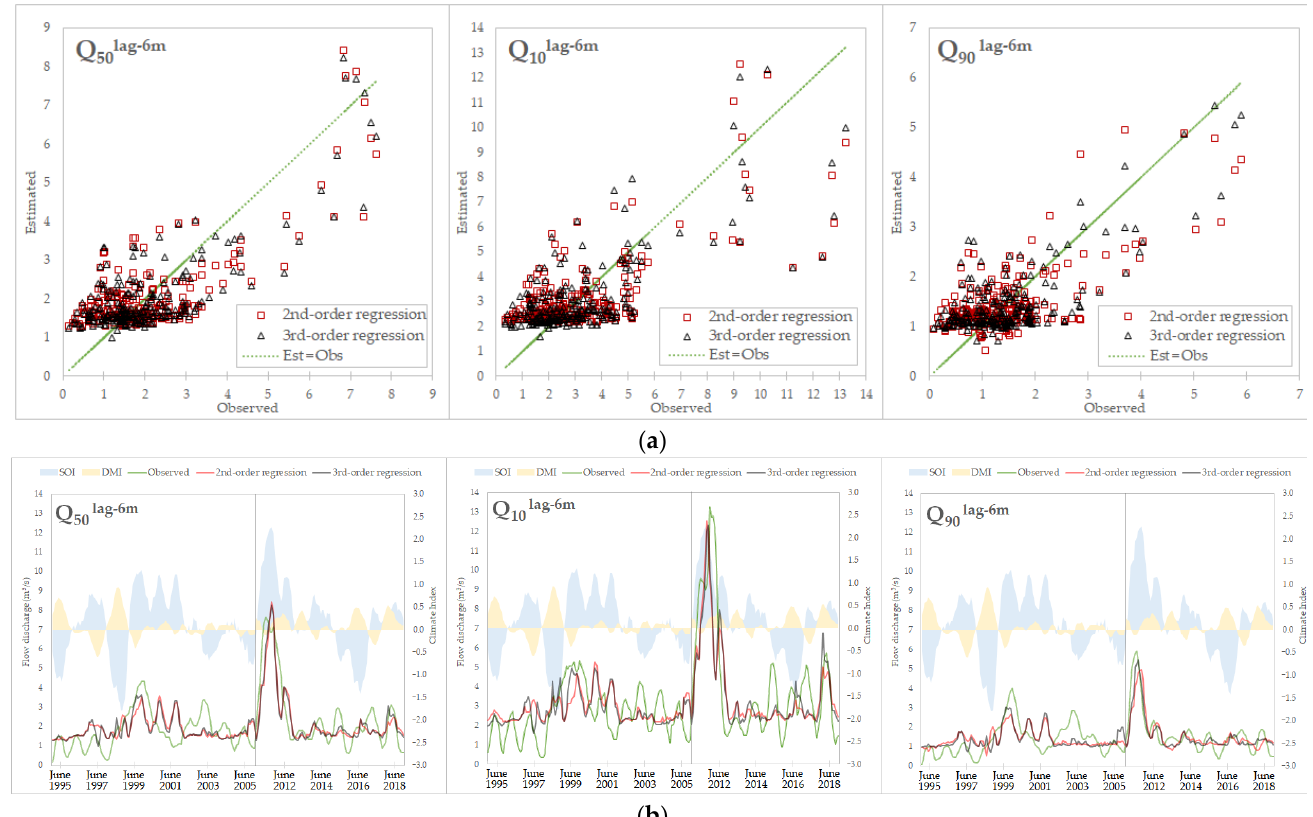
Figure 5. Comparison between the observed variables and the estimated flow regimes by 6-month lagged multiple poly- nomial regression model with 6-month moving average dataset. There are two figures: ( a ) The scatterplots of the estimated versus observed values; ( b ) The time series of observed (Q 50 , Q 10 , Q 90 , SOI, and DMI) and estimated (Q 50 , Q 10 , Q 90 ) values in 1994–2005 (left side of the separation line) and 2010–2018 (right-side of the separation line). The months showed at the x -axis are for the streamflow only. The months for the climate indices are 6 months before the streamflow months.